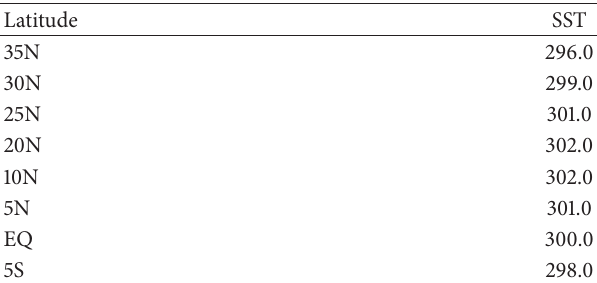
Table2:Latitudinaldistributionoftheseasurfacetemperatureused in the numerical